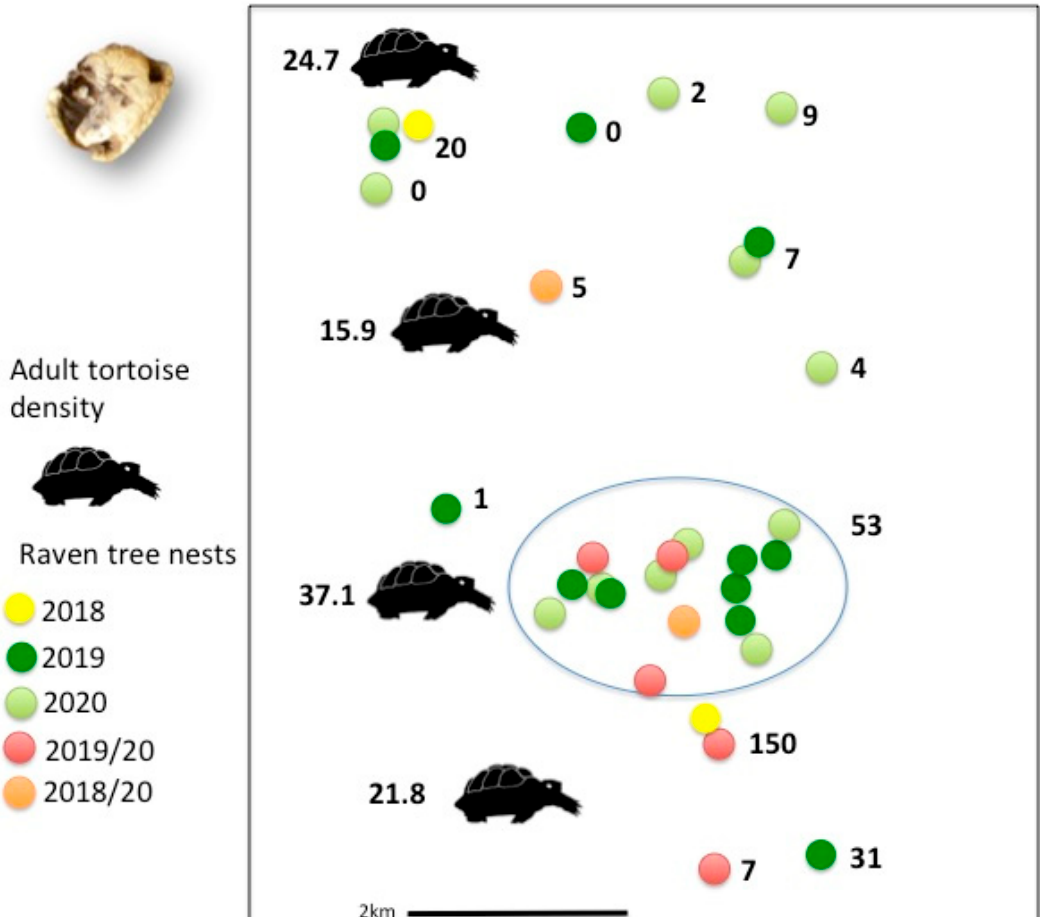
Figure 3. Spatial distribution of the number of predated young Spur-thighed tortoise Testudo graeca surrounding raven nests. The nests are differentiated by color as follows: in yellow, 2018; in dark green, 2019; in light green, 2020; those occupied in both 2019 and 2020, in red; and those occupied in all three years, in orange. The adult tortoise density (indiv/0.01 km 2 ) in the study area is also shown. The blue elipse highlights the aggregation of nests.